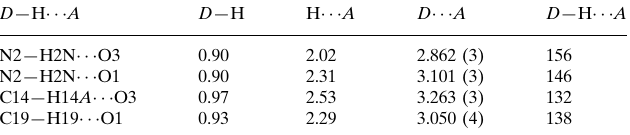
Hydrogen-bond geometry (A˚ , (cid:3)